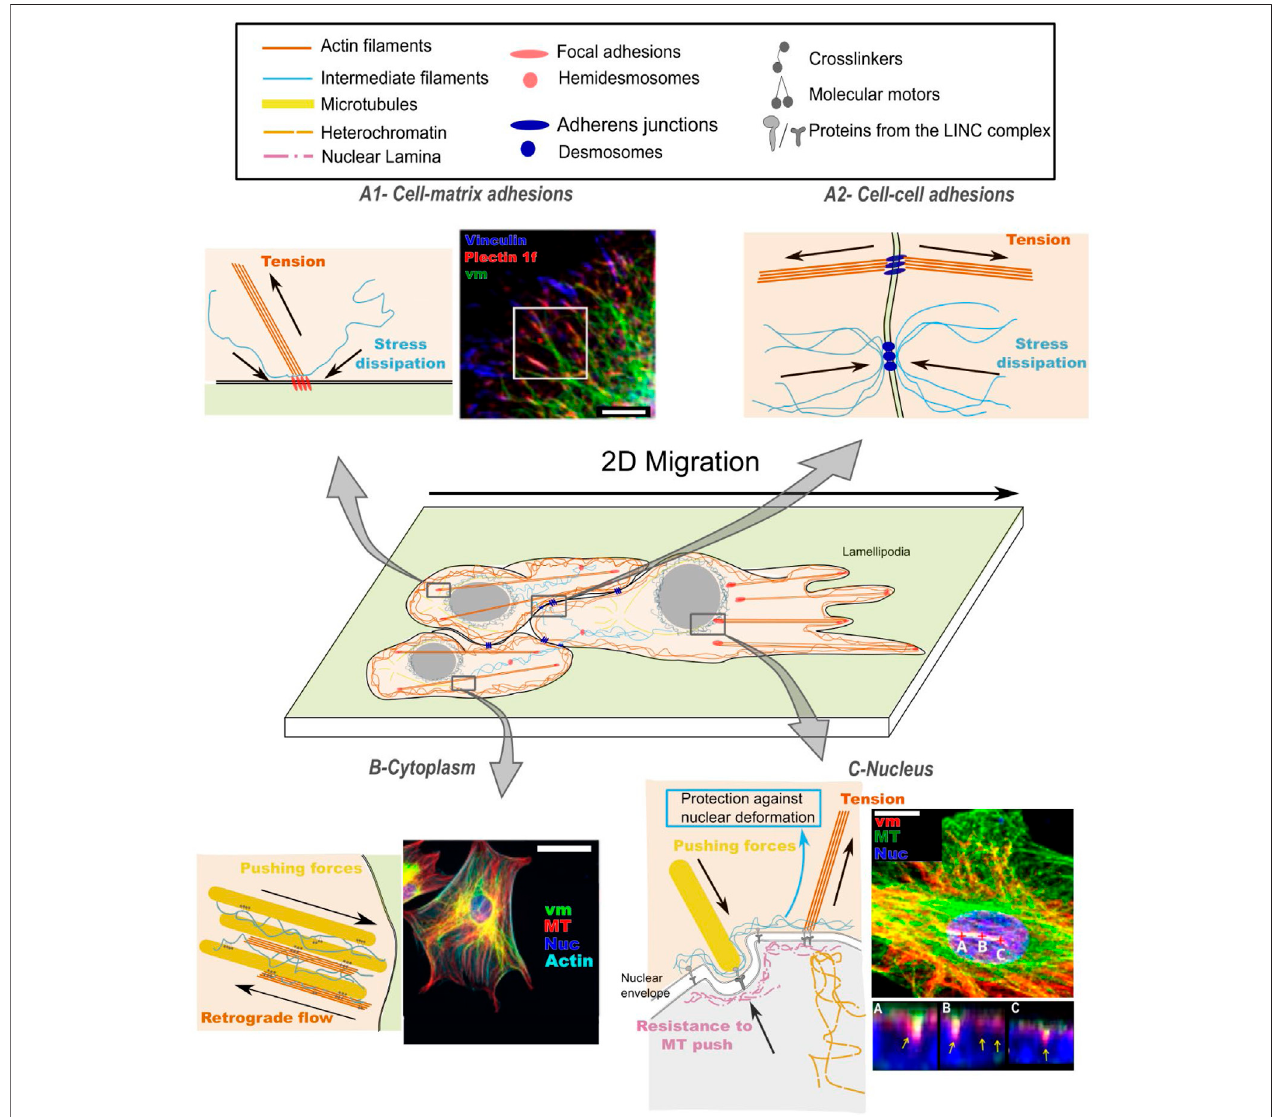
FIGURE1| Cytoskeletalcrosstalkbetweenintermediate fi laments(IFs),actin fi laments(AFs)andmicrotubules(MTs)contributestomechanosensing: (A) atthecell surface: mechanical signals emerging from the matrix (A1) or from neighboring cells (A2) ; (B) inthe propagation ofmechanical signals acrossthe cell cytoplasm and (C) up to the cell nucleus. (A1) At cell-matrix adhesions, actin/vimentin crosstalk regulates focal adhesion turnover, which results in dissipation of local stresses. Fluorescenceimagefrom(Gregoretal.,2014)showstheintimatespatialrelationbetweenvimentin(vm),plectinandvinculin,orchestratingfocaladhesionturnover; scale bar is 10 µm. (A2) At cell-cell adhesions, actin/intermediate fi lament crosstalk is activated upon tensile (pulling) forces and participates in the regulation of cellular prestress. (B) In the dense cytoplasm, mechanical forces are transmitted through all three cytoskeletal networks. The intermediate fi lament network affects the (de) polymerizationratesoftheothertwonetworks,andthethreenetworksco-align.Fluorescenceimagefrom(Vohnoutkaetal.,2019)demonstratesthedenseorganization of vimentin, microtubules (MT) and actin. Vimentin spans from membrane sites to the nucleus (DAPI) and forms a cage surrounding the nucleus. Scale bar is 50 µm. (C) At the nucleus, forces are transmitted between the cytoskeleton and chromatin through LINC complexes, affecting nuclear shape and heterochromatin density, while intermediate fi laments protect the nucleus from large deformations. Fluorescence image from (Feliksiak et al., 2020) shows microtubules and vimentin around the nucleus (DAPI); scale bar = 15 µm. Areas marked by A-B-C demonstrate the tight association of vimentin with nuclear grooves.